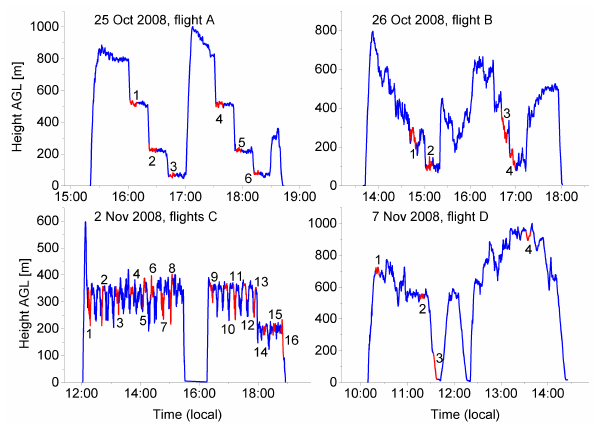
Fig. 2. Flight altitude above ground level versus local time; the sampling times are marked in red and numbered in chronological order.